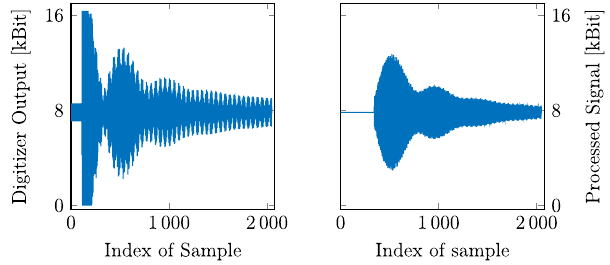
FIG. 8. Beam-excited TE 111 - 6 dipole mode in the time domain from the HOM electronics of the downstream coupler of cavity eight in ACC1. The sampling rate is 108 MHz. The measured raw signal (left) and the processed signal (right) are plotted. The oscillation of the raw signal in the first 100 samples is the calibration signal of the readout electronics. For this particular beam trajectory, the digitizer is in saturation till sample 180. Since it is in saturation till sample 343 for other beam trajectories, the processed signal is cut till that point for all trajectories to ensure a quantitative comparison.